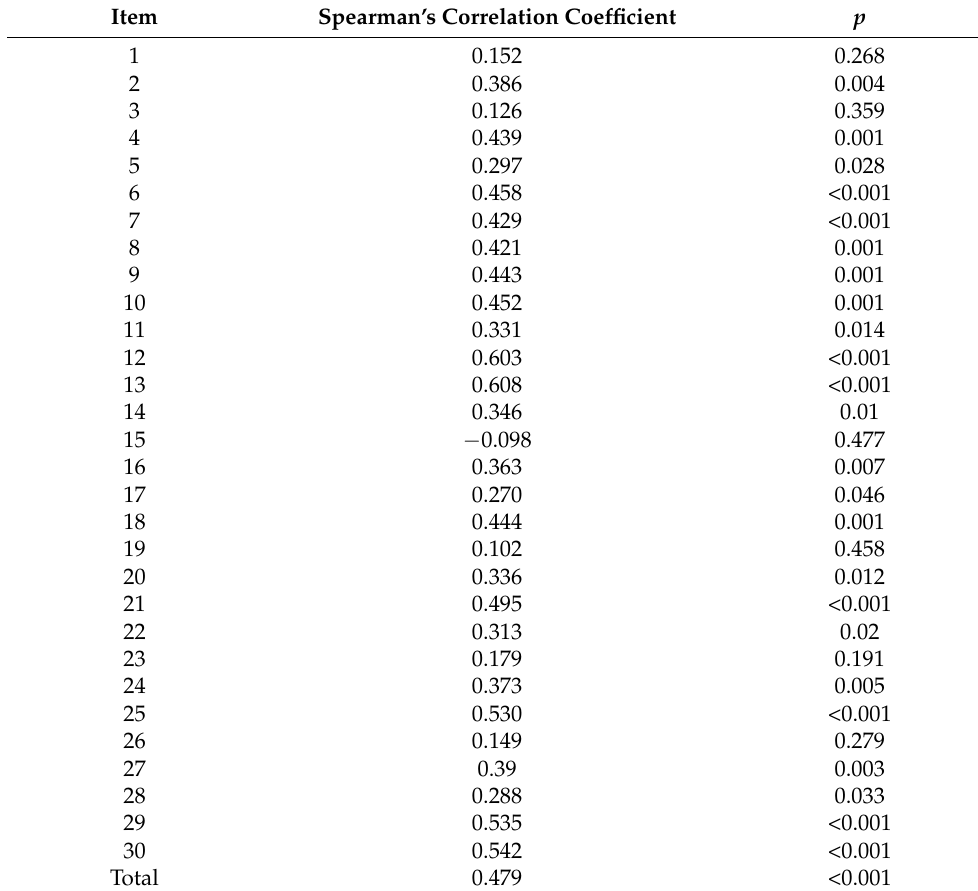
Table 4. Spearman’s correlation coefficient of the GDS-30 scale ( n =